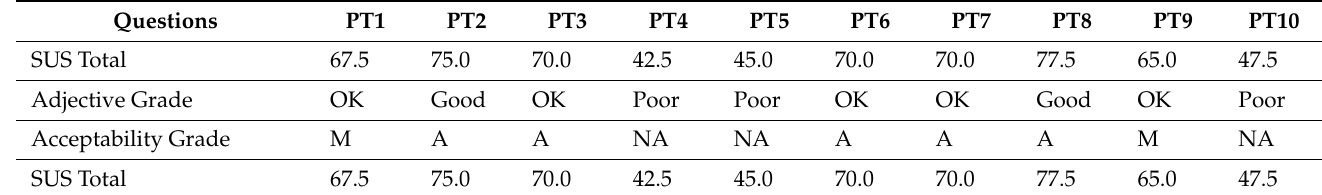
Table 4. Baseline knowledge and prior experience questionnaire. All included questions are depicted with the respective answers provided by each participant. Note that only the first question allowed multiple